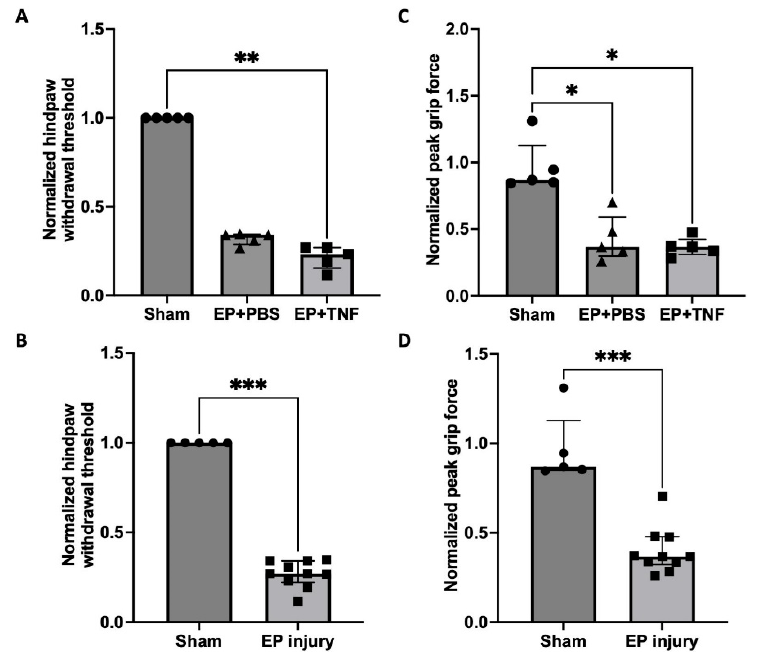
Figure 2. EP injury increased sensory hypersensitivity behaviors, demonstrating mechanical allo- dynia and axial spinal discomfort with no effect of injectate. ( A ) EP injury with TNF α injection de- creased the normalized hindpaw withdrawal threshold. ( B ) Combined EP injury decreased the nor- malized hindpaw withdrawal threshold. ( C ) EP injury with PBS and TNF α injections decreased the normalized peak grip force. ( D ) Combined EP injury decreased the normalized peak grip force. * p < 0.05. ** p < 0.01. *** p < 0.001.